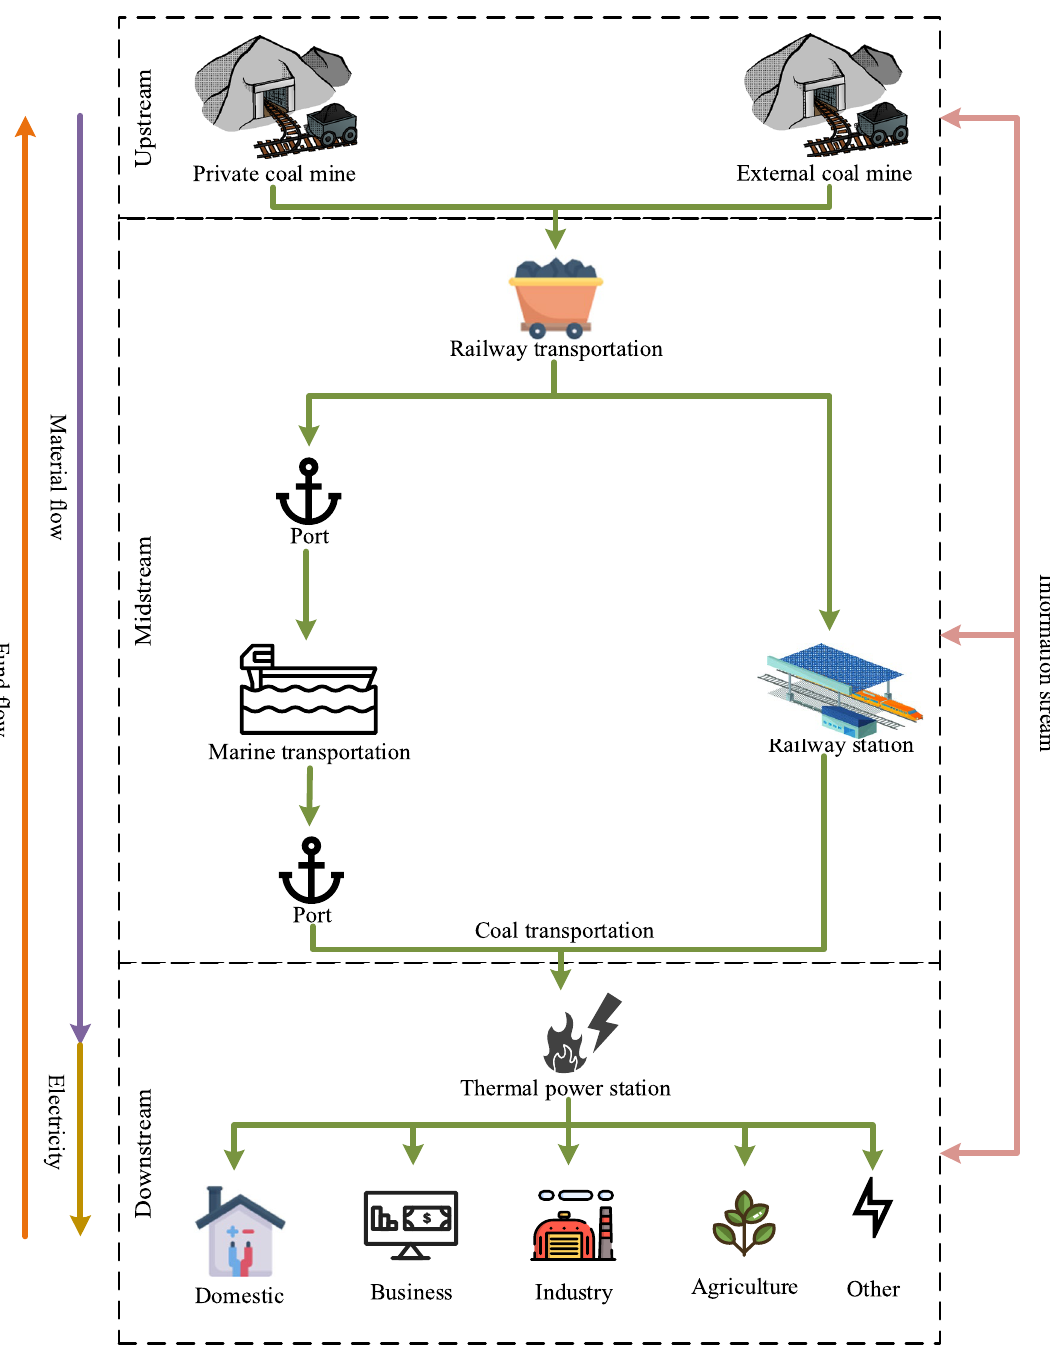
Figure 2. The structure of coal supply chain in coal-electricity-integrated